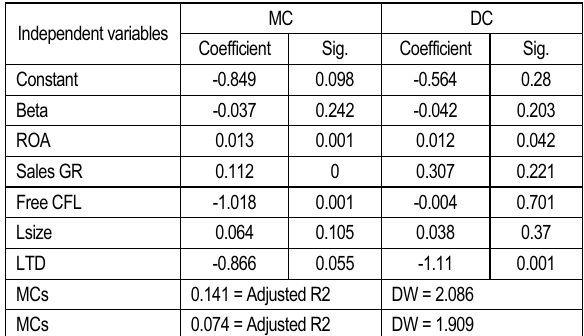
Table 7. Regression